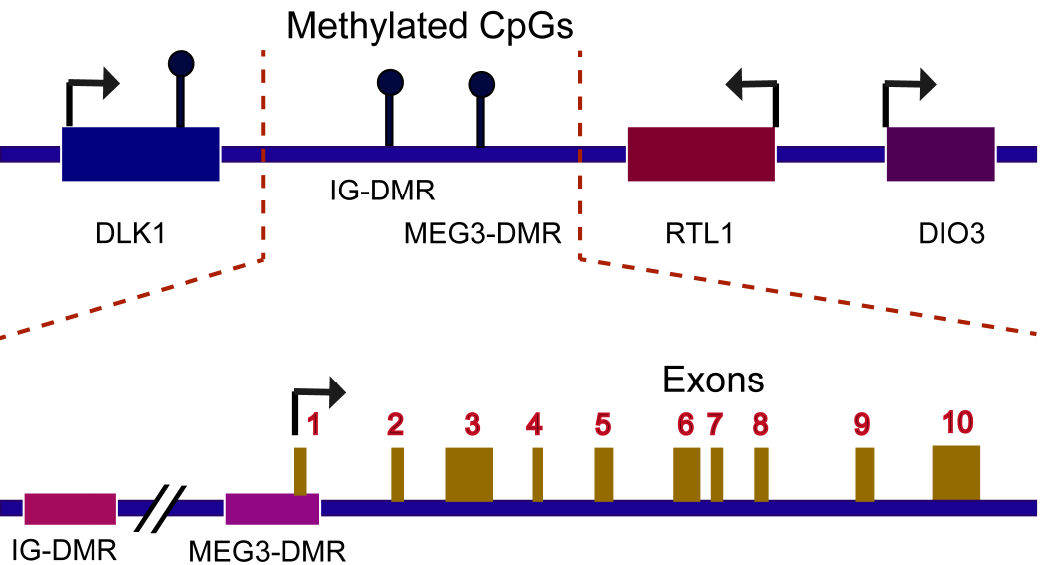
Figure 1. Schematic diagram of DLK1-MEG3 locus on human chromosome 14. The 837 kb-long DLK1-MEG3 locus contains the protein-coding genes DIO3, RTL1, and DLK1. The MEG3 gene has ten exons and is 35 kb long. The IG-DMR is 13 kb upstream of the MEG3 gene. The MEG3-DMR overlaps with the MEG3 promoter. IG-DMR: intergenic differentially methylated region.